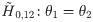
Rejection regions for surrogate closed testing.Plot of rejection region for tests under the surrogate closed testing procedure. The test of homogeneity H˜0,12:θ1=θ2 will reject the null hypothesis at level α for values (θ^1,θ^2) outside of the black diagonal band. If the surrogate test is significant at level α, the test of H0,1: θ1 = 0 then rejects outside of the green bar, and that of H0,2: θ2 = 0 rejects outside of the red bar.